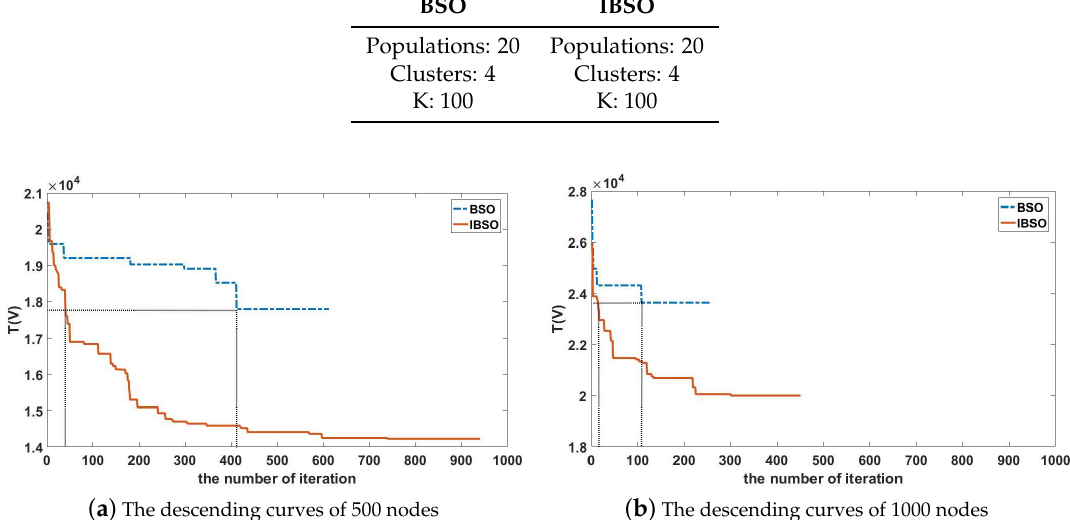
Table 2. Parameter setting of the brainstorm optimization (BSO) and the improved BSO (IBSO).